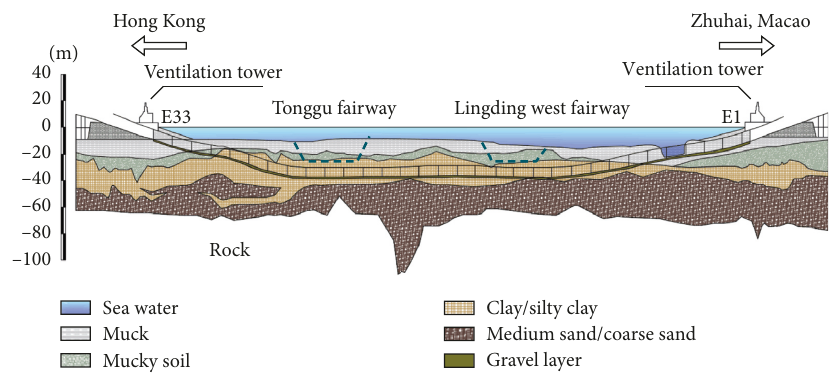
Figure 1: Geological section